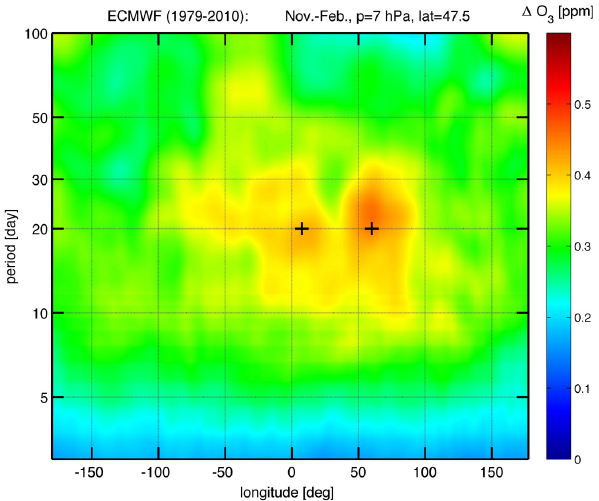
Fig. 2. Mean envelopes of temporal ozone fluctuations as function of longitude and period for the latitude belts at 47.5 ◦ N during win- ter (1 November–28 February). ERA Interim data of ozone volume mixing ratio at 7hPa from 1979 to 2010 were analysed. Two crosses at 7.5 ◦ E and 60 ◦ E indicate the locations where the 20-day oscilla- tion is maximal. The ozone time series at 7.5 ◦ E, 47.5 ◦ N and 60 ◦ E, 47.5 ◦ N are selected in the following.